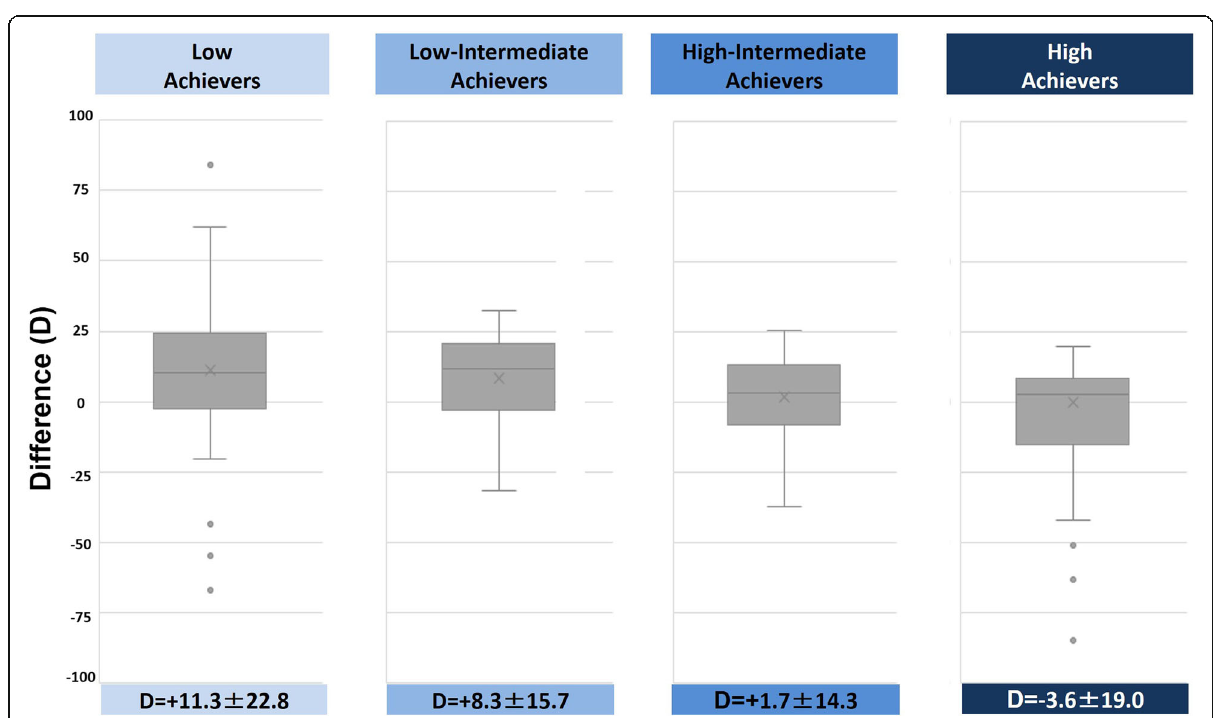
Fig. 3 Comparison of pre and posttest results according to groups defined by pretest scores. Difference = (posttest score) − (pretest score). The